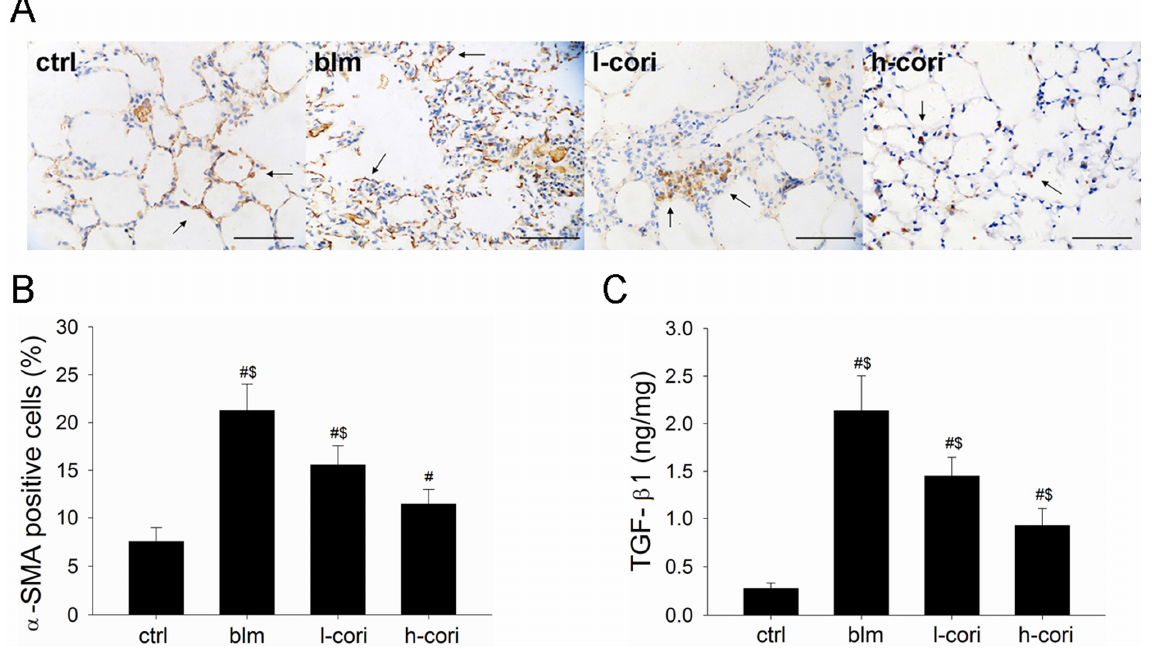
Figure 8. Corilagin inhibited α -SMA expression and TGF- β 1 production after bleomycin-induced lung injury. ( A ) Immunohistochemical staining of α -SMA. The whole cells were brown-stained (arrow). Scale bars represent 200 µm; ( B ) Average proportions of α -SMA positive cells in 200 times-magnified fields; ( C ) Content of TGF- β 1 in lung homogenate samples. #: p < 0.05 compared with the ctrl group; $: p < 0.05 compared with the blm